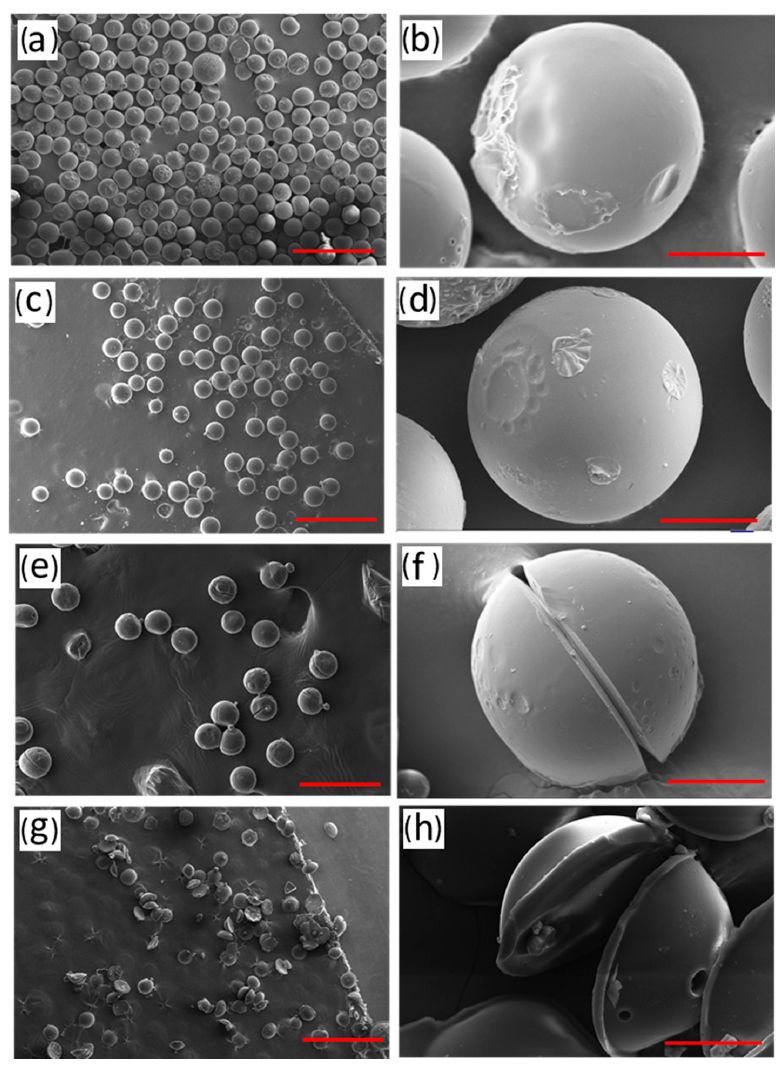
Figure 3. SEM images of RF microspheres with different solidification temperatures: ( a , b ) 100 °C; ( c , d ) 110 °C; ( e , f ) 120 °C; ( g , h ) 130 °C; the scale bar for ( a , c , e , g ) and ( b , d , f , h ) is 500 µm and 50 µm, respectively.